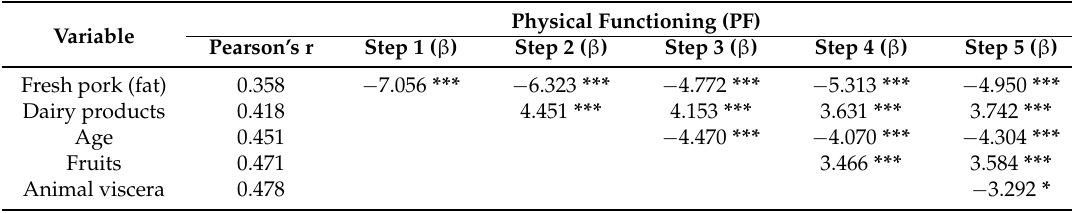
Table 3. Stepwise regression predicting the PF scores.